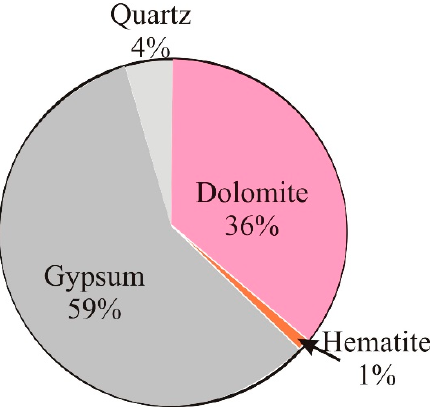
Figure 9. Estimated mineral composition of sediments from the solution of the settling pond (A01).